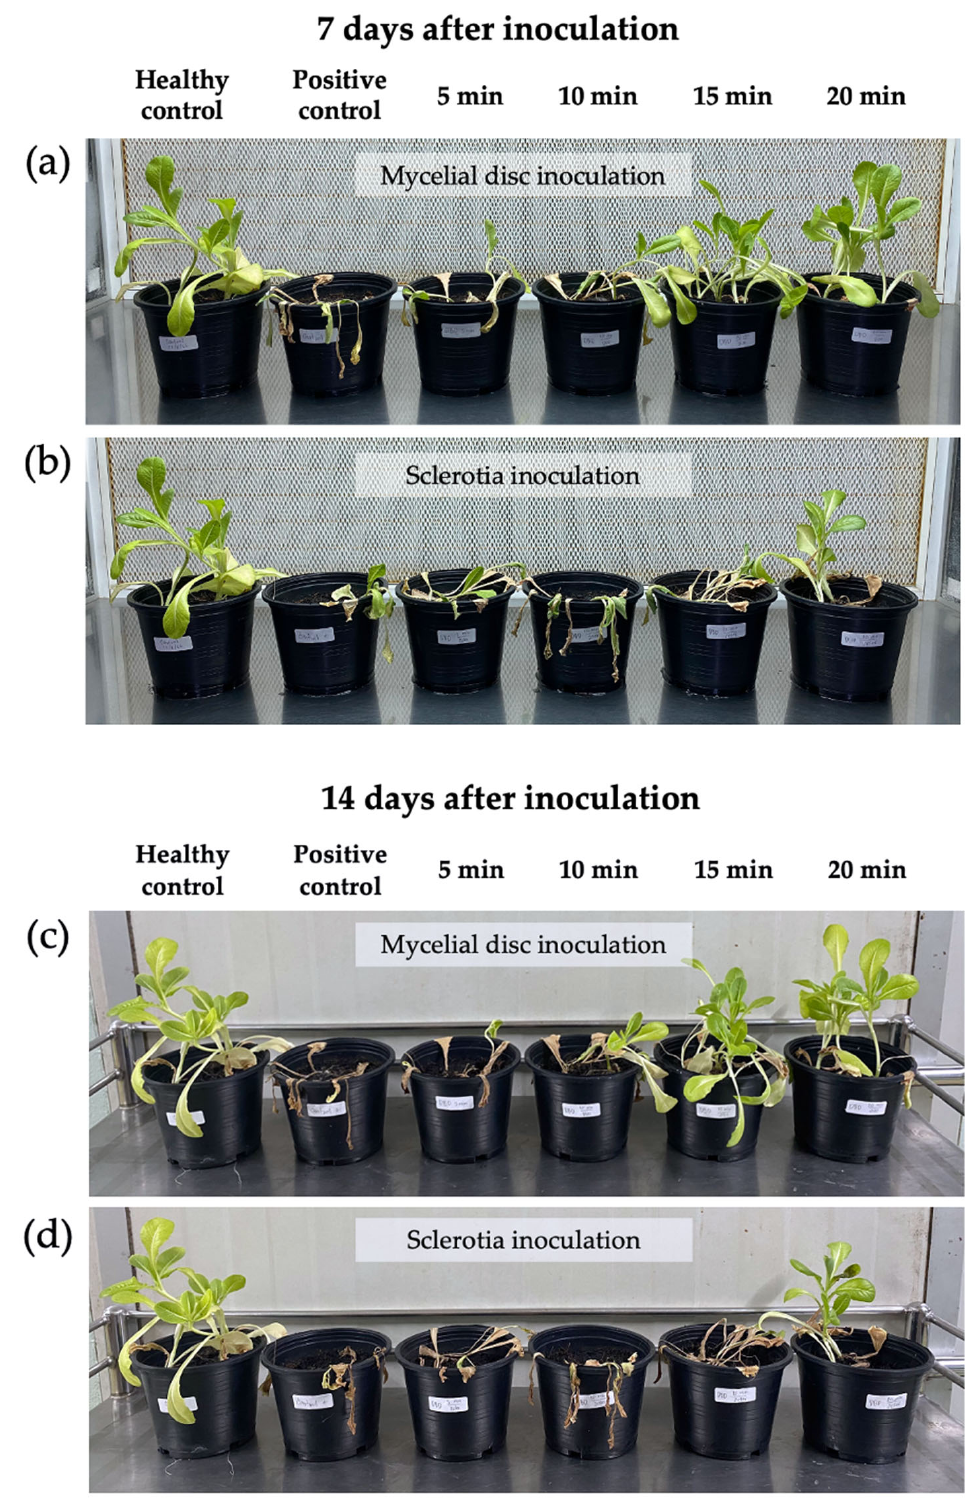
Figure 5. Pathogenicity assays of Athelia rolfsii after DBD plasma exposure, for different durations of 5, 10, 15, and 20 min, showing lettuce plants inoculated with ( a ) fungal mycelial discs at 7 days after inoculation; ( b ) sclerotia at 7 days after inoculation; ( c ) fungal mycelial discs at 14 days after inoculation; ( d ) sclerotia at 14 days after inoculation.